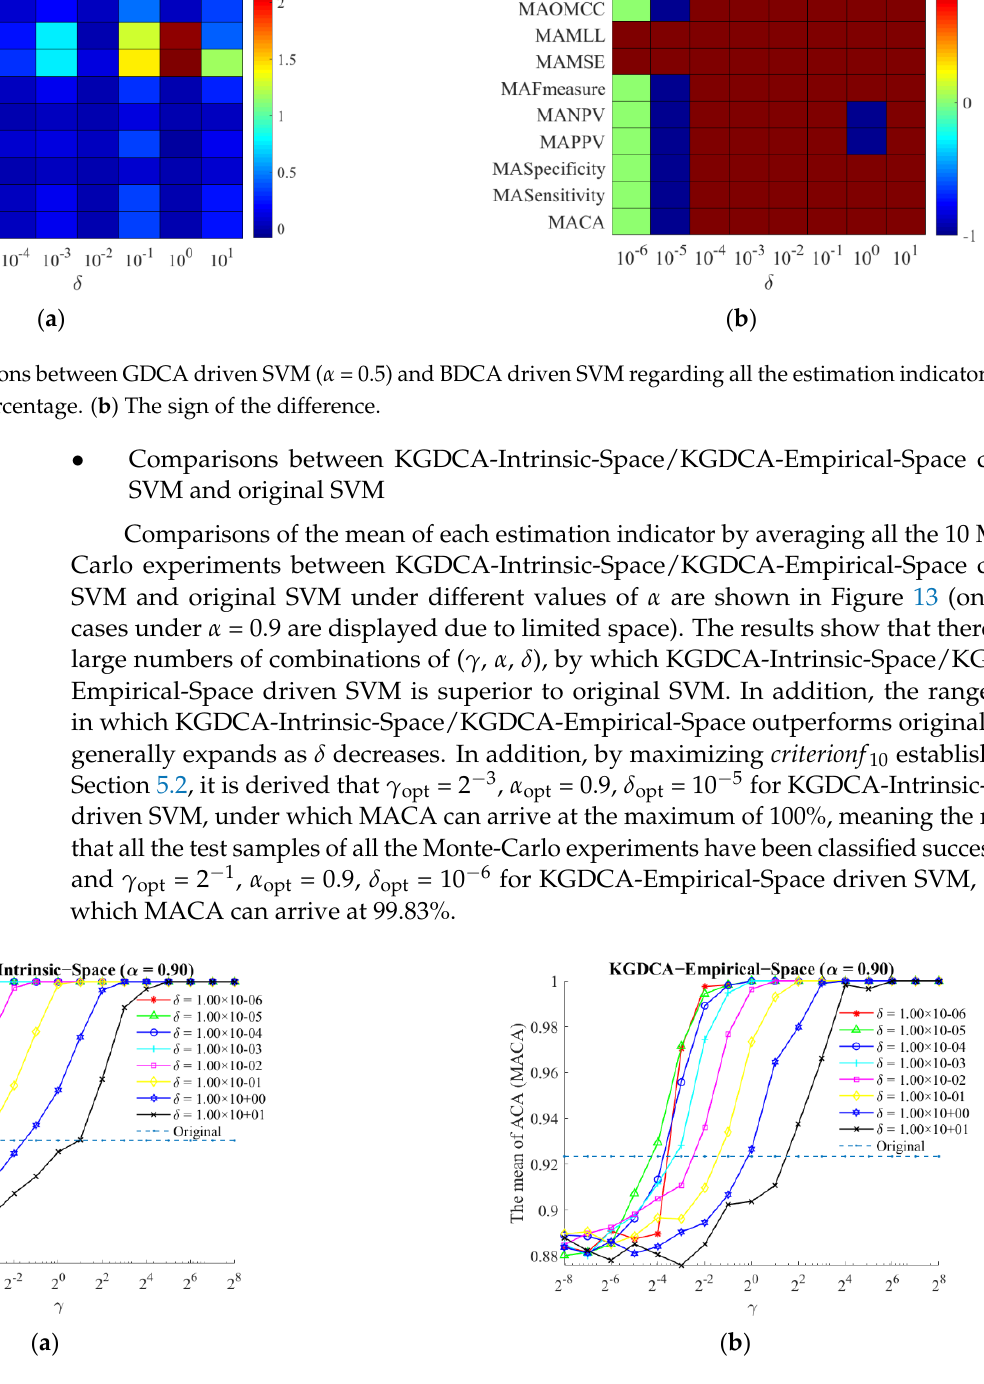
Figure 12. Comparisons between GDCA driven SVM ( α = 0.5) and BDCA driven SVM regarding all the estimation indica- tors. ( a ) The increased percentage. ( b ) The sign of the difference.